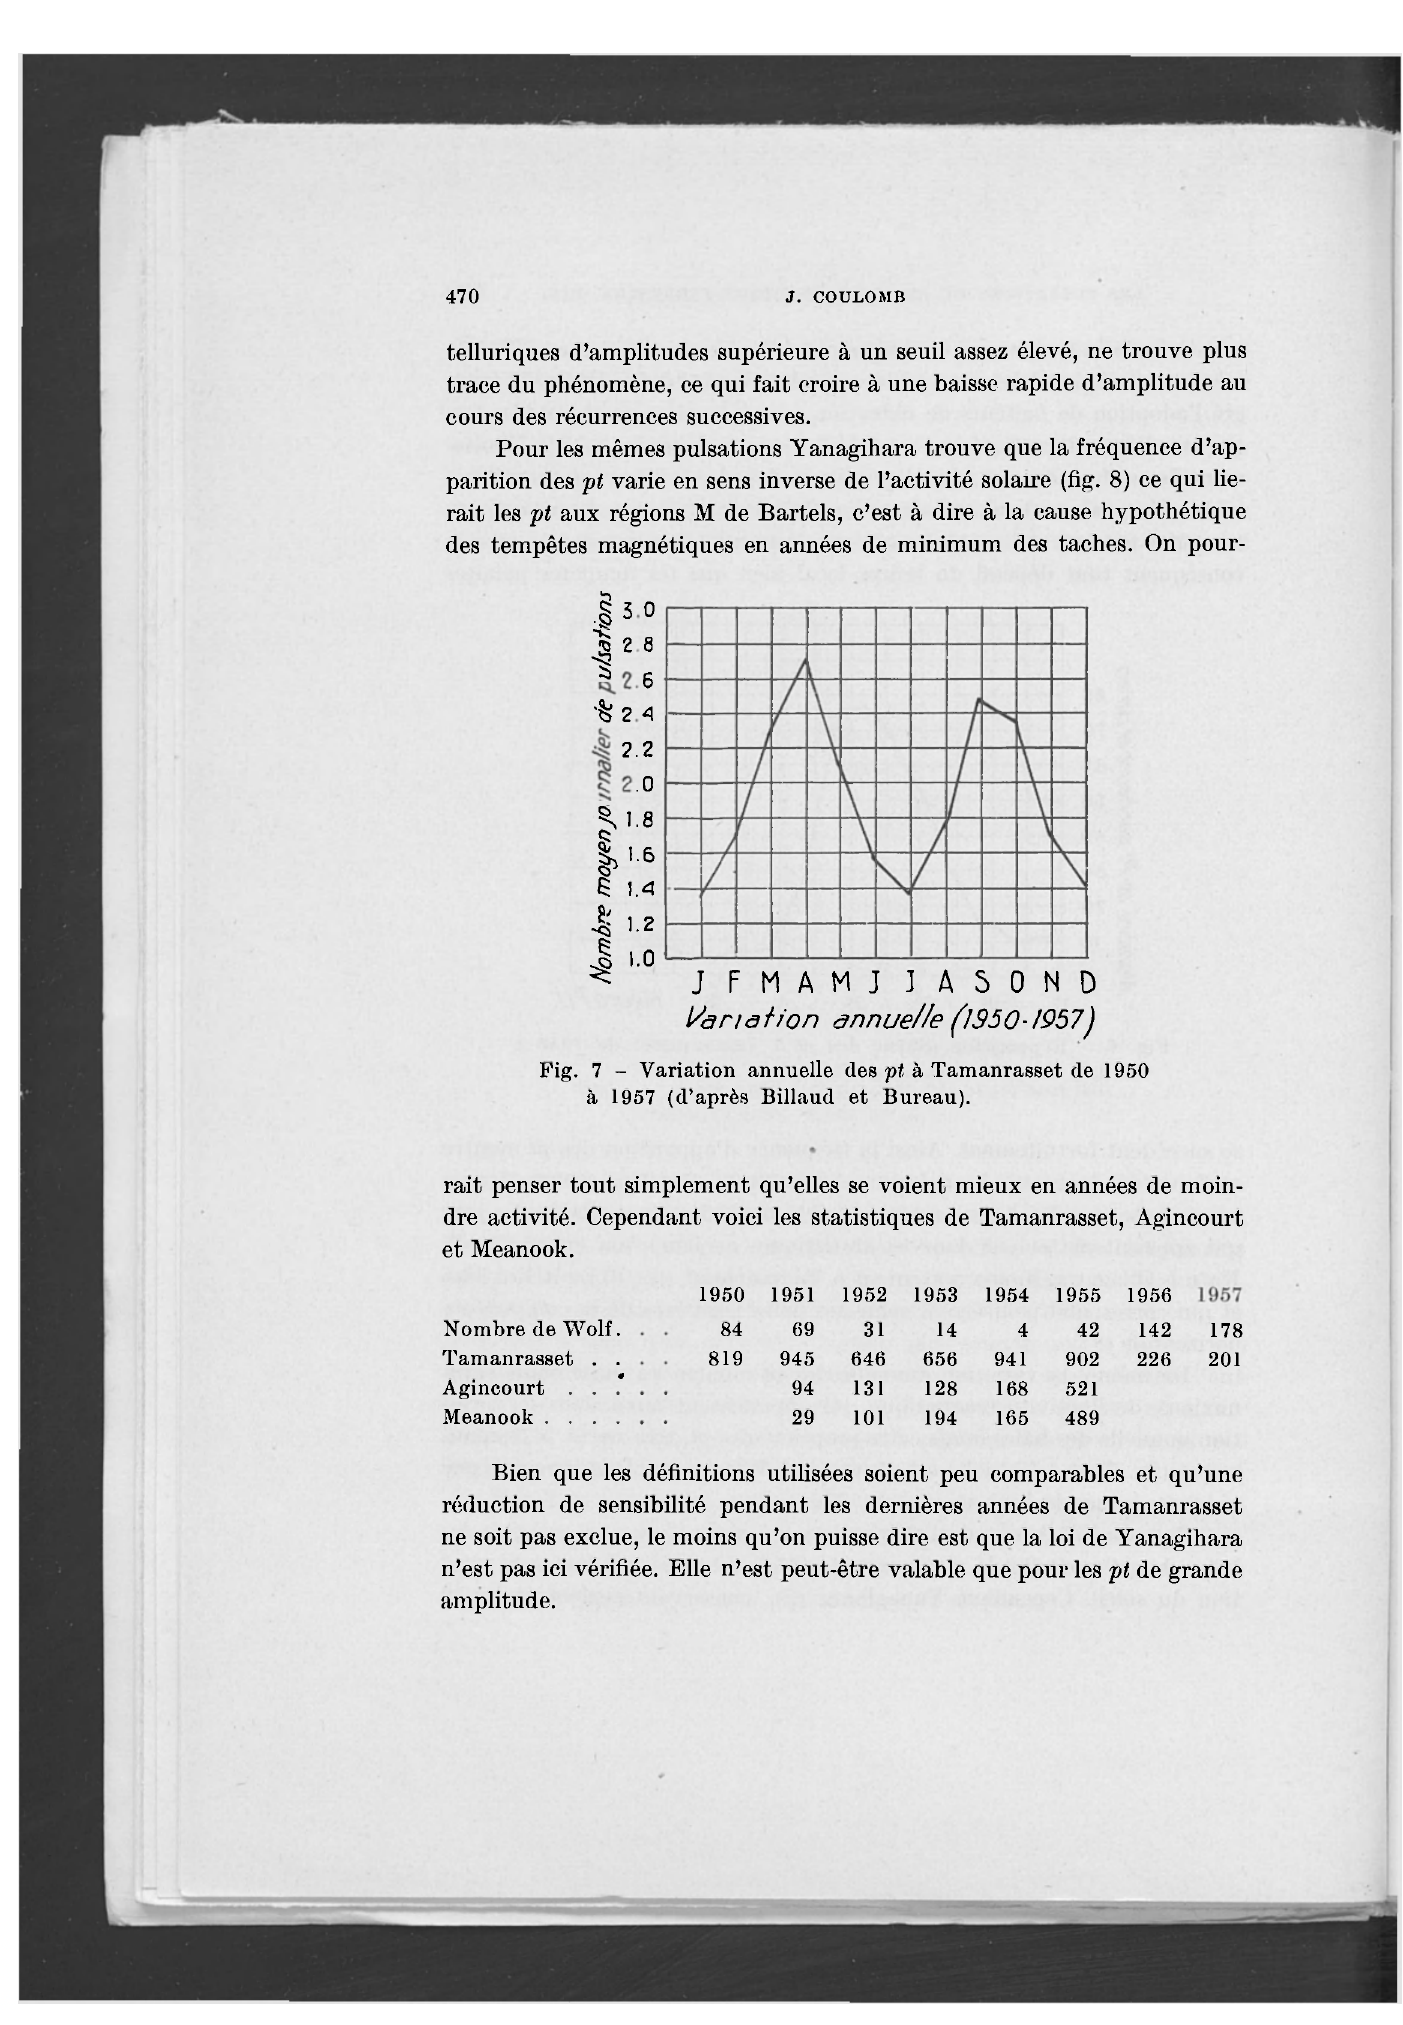
Fig. 7 - Variation animelle des pt à Tamanrasset de